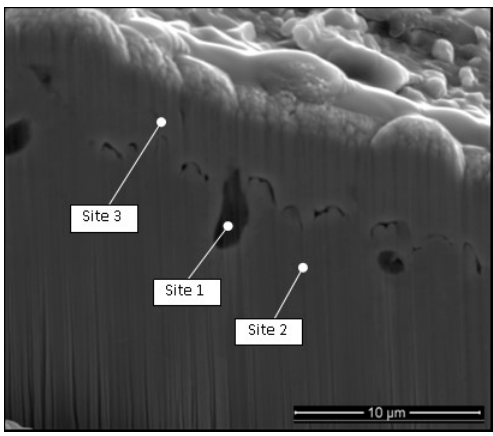
Figure 10. Cross-section SEM image of SS 316L sample in the weld zone after 100 h heating.